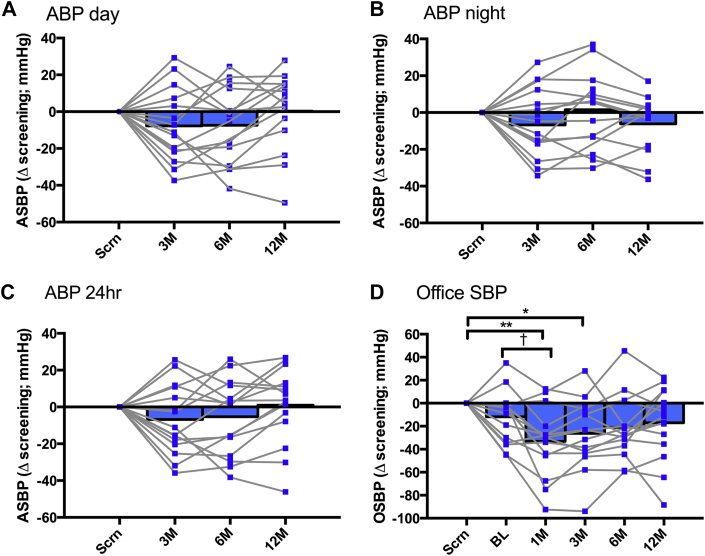
Blood Pressure Responses in the Total Cohort Before and After uCB Resection (n=15)Ambulatory systolic blood pressure (ASBP), (A) day, (B) night, and (C) 24 h, at screening and at 3-, 6-, and 12-month follow-ups. (D) Office systolic blood pressure (OSBP) at screening, baseline, and at 1-, 3-, 6-, and 12-month follow-ups. The 1-way repeated measures analysis of variance with Tukey test for multiple comparisons was used. Night: 12:00 am to 5:59 am; day: 6:00 am to 11:59 pm. *p = 0.038; **p = 0.007; †p = 0.0298. ABP = ambulatory blood pressure monitor; BL = baseline; M = month; Scrn = screening.